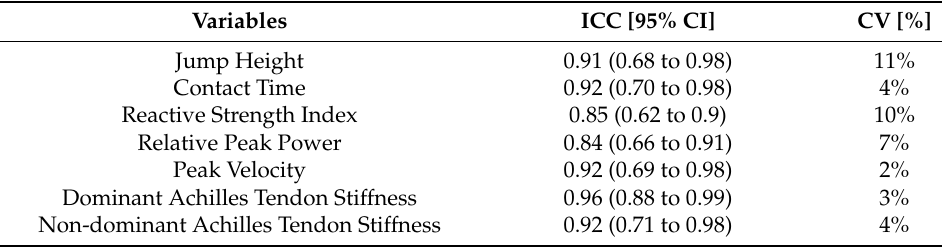
Table 1. Intersession reliability of the drop jump performance, Achilles tendon stiffness.